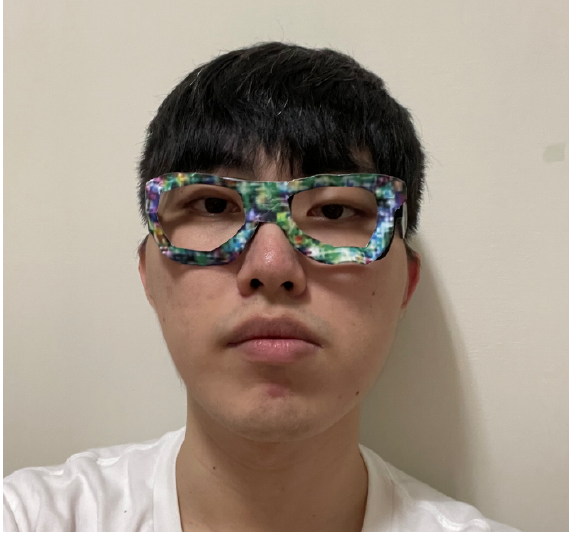
Figure 8. Wearing of adversarial glasses in the physical